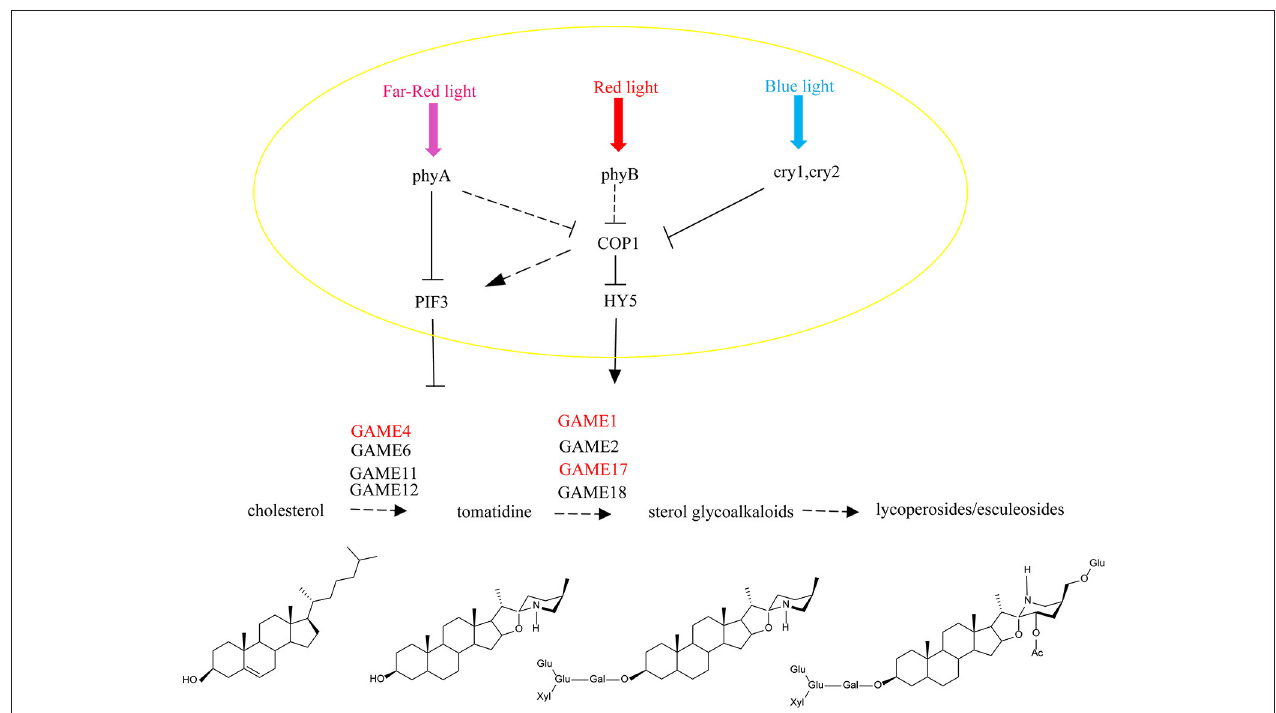
FIGURE 9 | A model for light signal transmission control of the steroidal alkaloid pathway. HY5 activates the biosynthesis of SGAs in tomato and PIF3 represses gene expression across the biosynthesis pathway by independently binding to the SlGAME1 , SlGAME4 , and SlGAME17